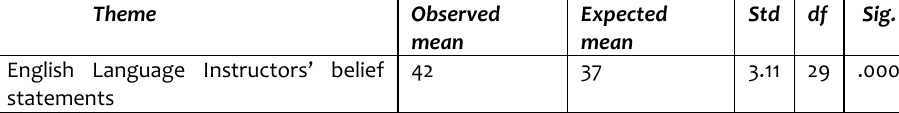
Table 2: One sample t-test results on teachers’ beliefs of reading strategies